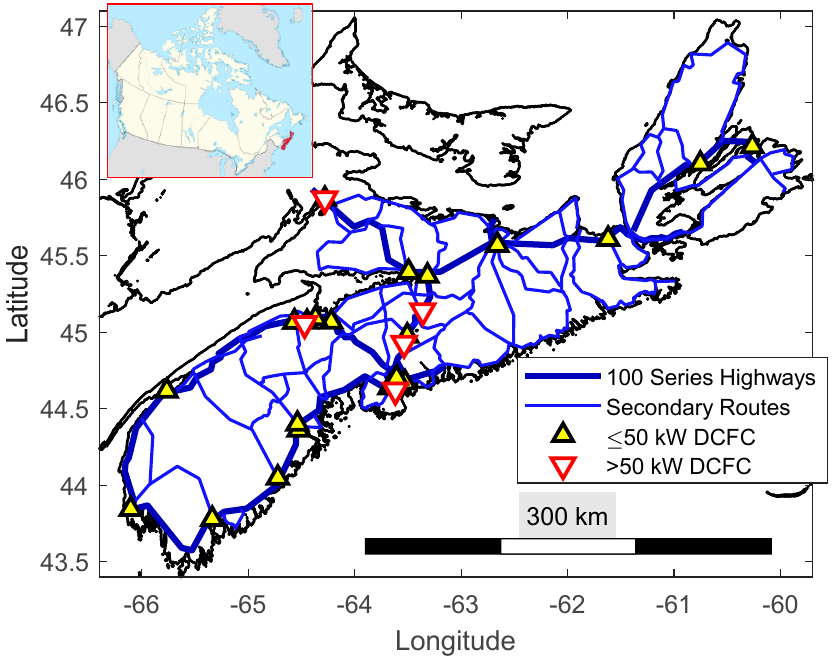
Figure 1. Map of Nova Scotia’s primary (‘100 series’) highways and major secondary routes. The location of Nova Scotia in eastern Canada is shown for context (inset).